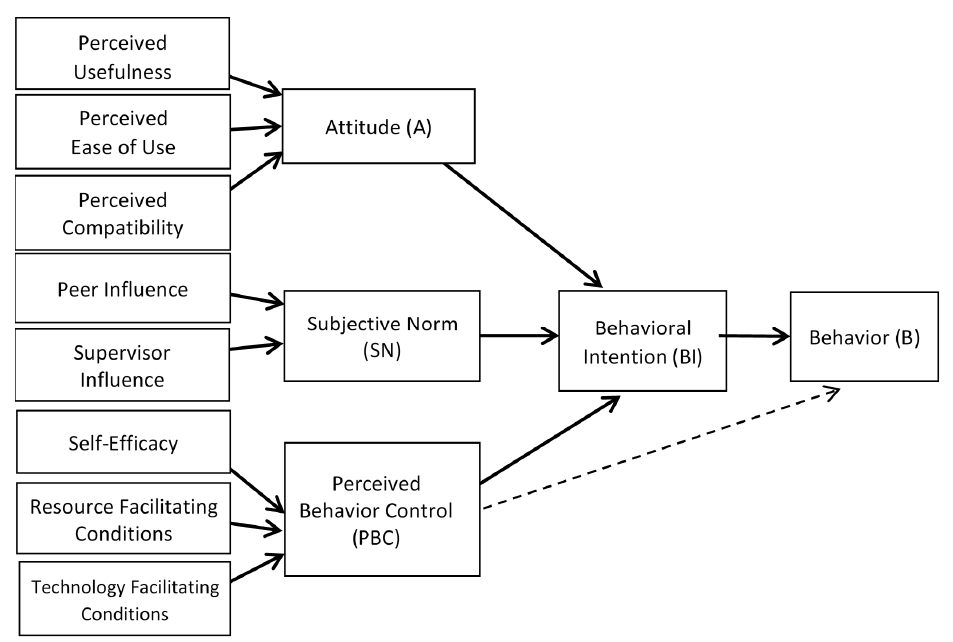
Figure 1. Deconstruction of the theoretical model of projecting behavior. Adaptation from: Taylor, S., and Todd, P.A. (1995) Understanding information technology usage: A test competing models. Information System Research, 6 (2), 144–176 [25].